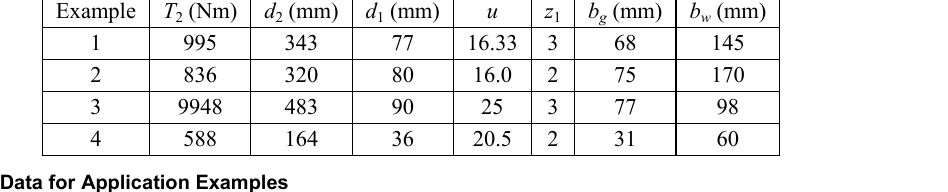
Table 2: Computed Data for Application Examples